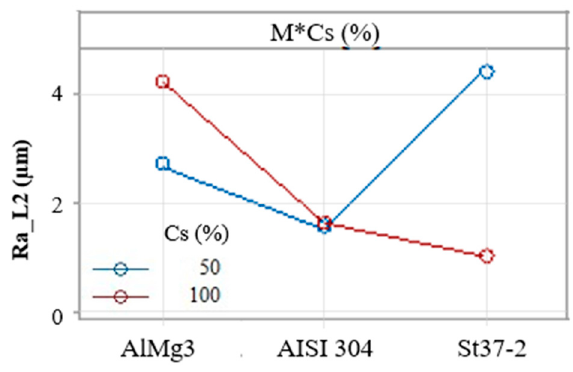
Figure 14. Interaction plot for arithmetic surface roughness.